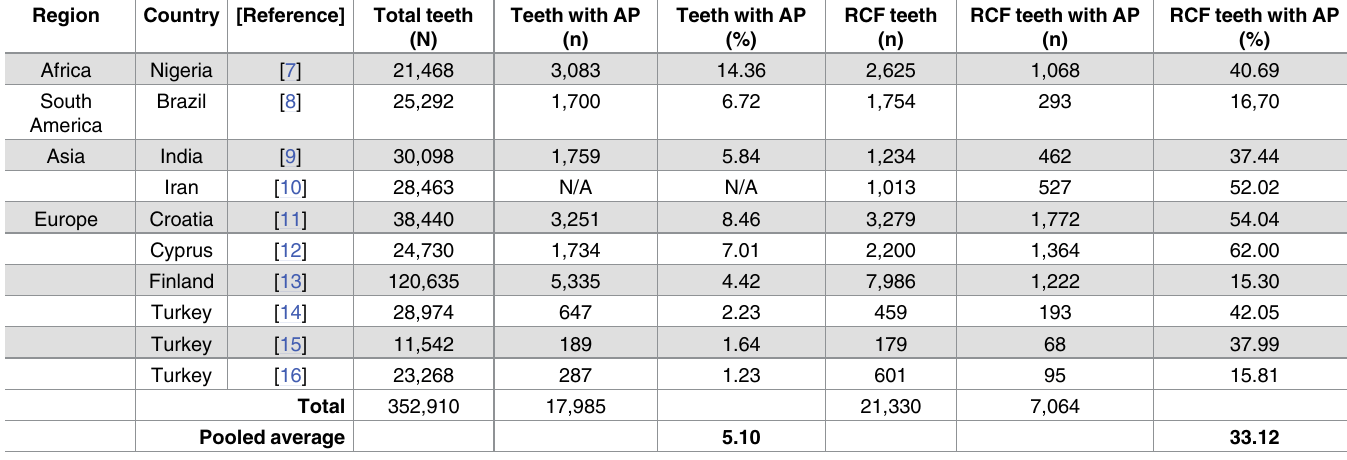
AP (apical pathosis); RCF (root canal